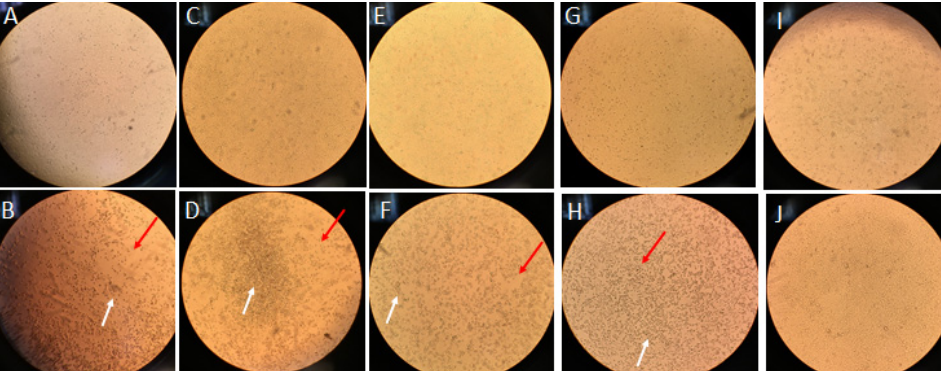
Figure 2. Human coronavirus (HCoV-OC43) in titer of 2.3 × 10 11 virus particles VP/mL was irradiated with various diodes, then irradiated VP infected the VeroE6 cell cultures. A lack of cell morphological changes in the cell culture infected with irradiated HoV-OC43 was documented for diodes as follows: ( A ) J275 at 40 ″ ; ( C ) 260 at 11 ′ 40 ″ ; ( E ) 255 J at 3 ′ 45 ″ ; ( G ) 250 J at 10 ′ 17 ″ . CPE was assessed through daily observation of infected cultures with irradiated viruses ( A , C , E , G ) vs. nonirradiated ( B , D , F , H ): pyknotic shrinking cells were noted; the white arrow points to cell rounding in a focal pattern and the red arrow points to cytoplasmic stranding. Swelling and clumping of cells was observed. Infected cells grow and clump together in “grape-like” clusters. ( I , J ) Uninfected cultures distinguishing normal cell changes that occur as cells age. Inverted light microscope at 100× . Table 3. Infectious titer reduction of the human coronavirus (HCoV-OC43) using the UV-C diodes. Determination of the virus particle concentration by UV